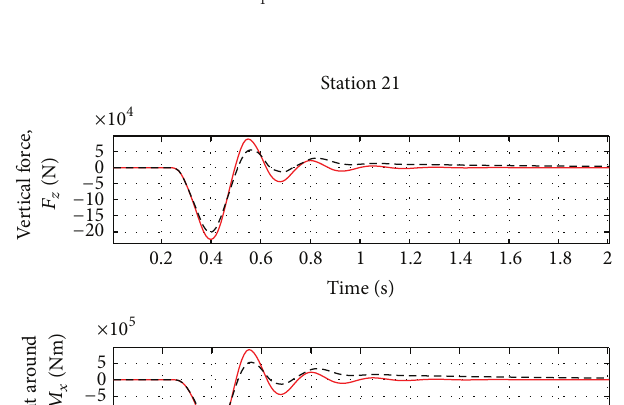
Figure 1: L 1 controller architecture.